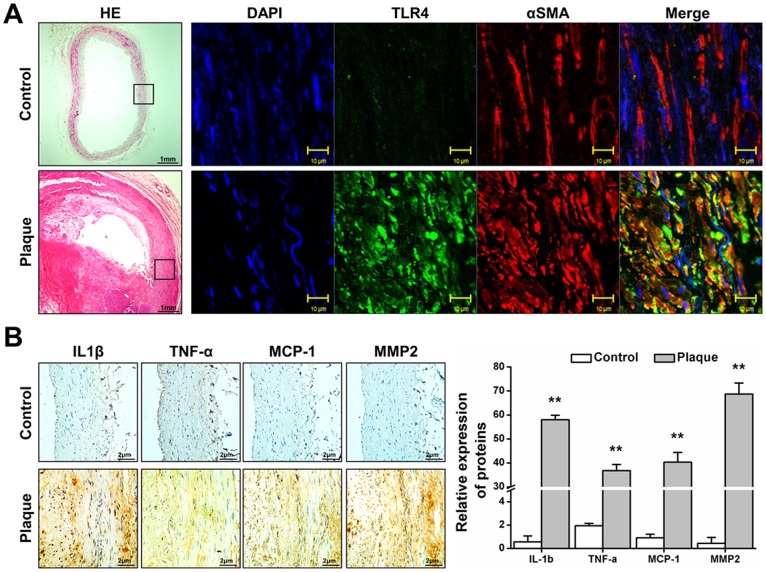
Expression of TLR4 and inflammatory cytokines in the SMCs of plaques.Human femoral arteries from patients with angiographic atherosclerotic plaques and interal thoracic artery without plaque were assessed by histological and immunochemical analysis. (A). Sections were stained with hematoxylin and eosin. Or immunofluorescence stains of αSMA and TLR4. (B) Immunohistochemical stains of IL-1β, TNFα, MCP-1 and MMP2; counterstained with hematoxylin. H&E is shown at 40×magnification, and immunofluorescence is shown at 1200× magnification B is shown at 200× magnification. Results are representative of 3 independent experiments. The expression levels of IL-1β, TNF-α, MCP-1 and MMP-2 detected by IHC were determined by assessing its staining using software image pro-plus 6.0. The results were showed as integrated optical density (IOD)/area. Three different sections and five different fields in each section have been detected. (n = 3, Mean±SD, **P<0.01 compared with control).